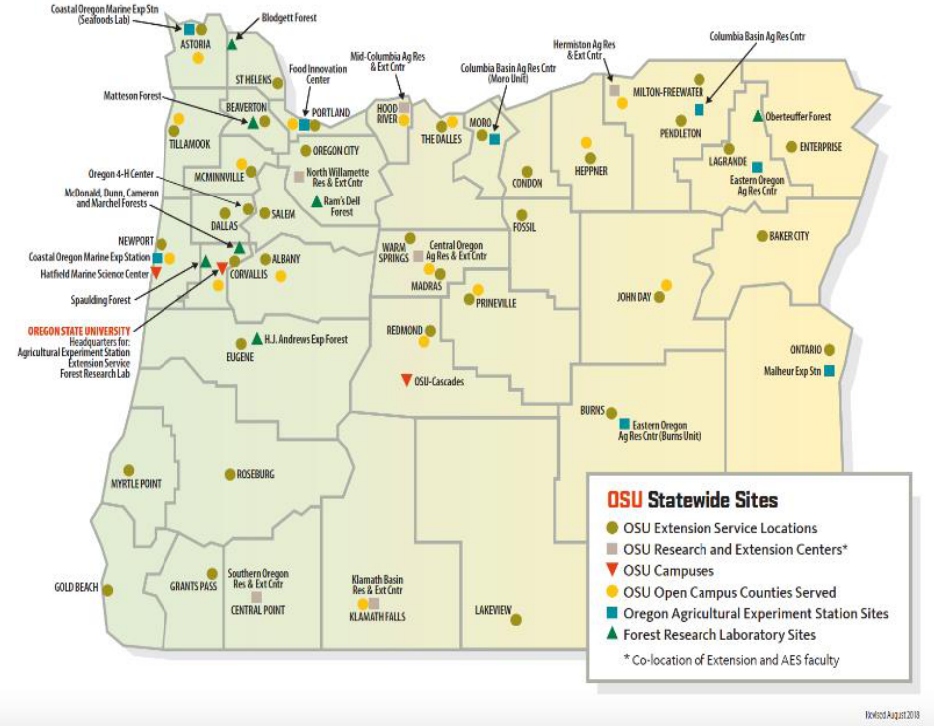
Figure 1. Oregon State University’s statewide presence includes agricultural experiment stations and re-search centers at 14 locations and an Extension Service presence in all 36 counties. (Image credit: Oregon State University; Source https://ourimpact.oregonstate.edu/) (accessed on March 10,